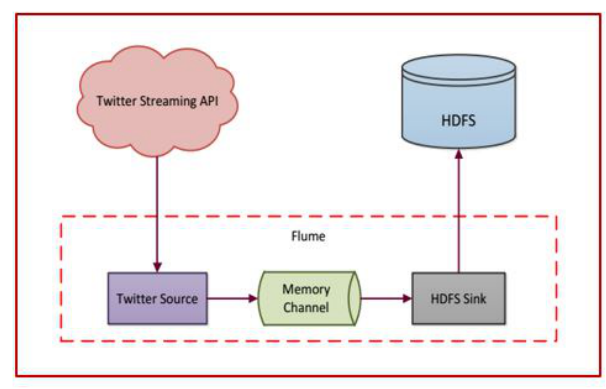
Figure 2. Flume architecture for the tweets collection